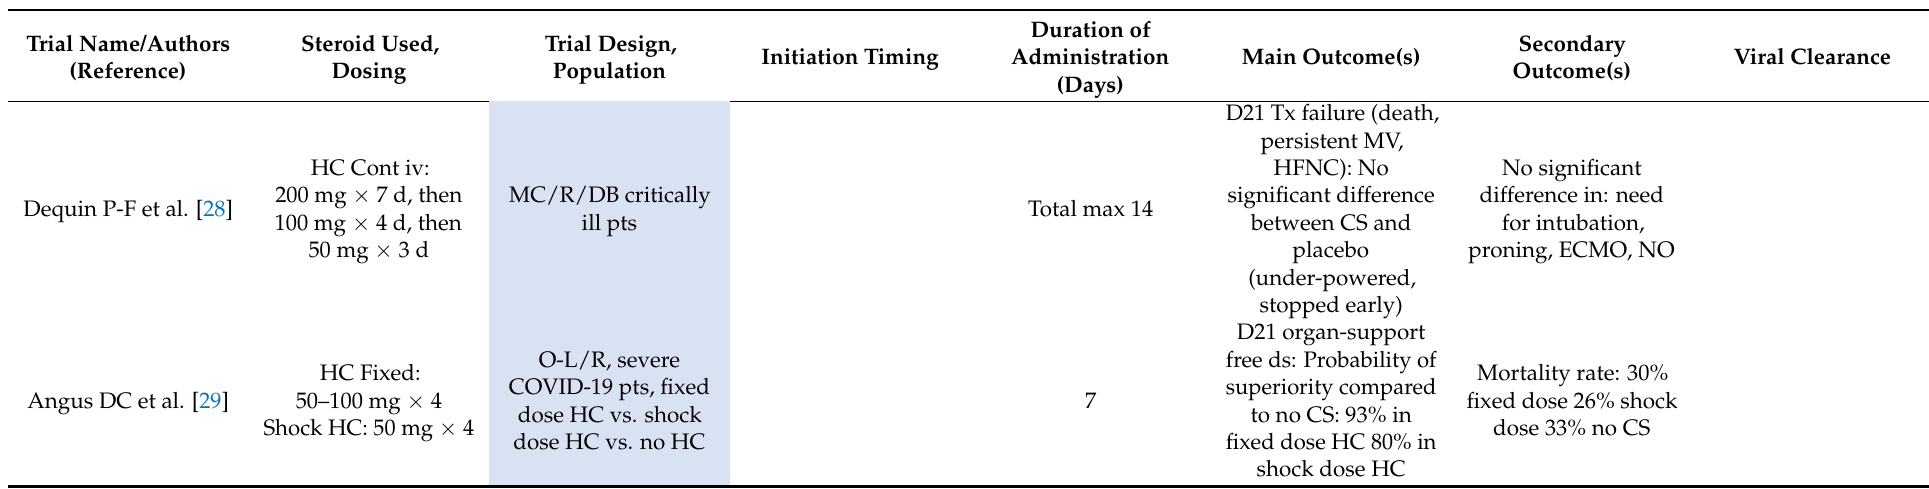
Table 3. Trials using hydrocortisone (HC); design (R = randomized in blue), timing, duration, outcomes (focusing on mortality data), and viral